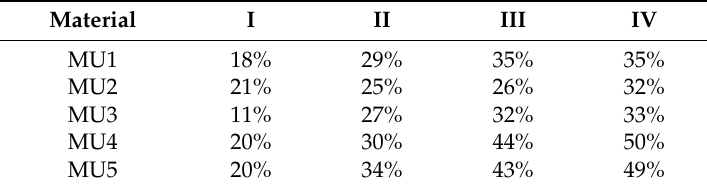
Table 8. Percentage value of the shape retention rate (R f ) after the rest period.